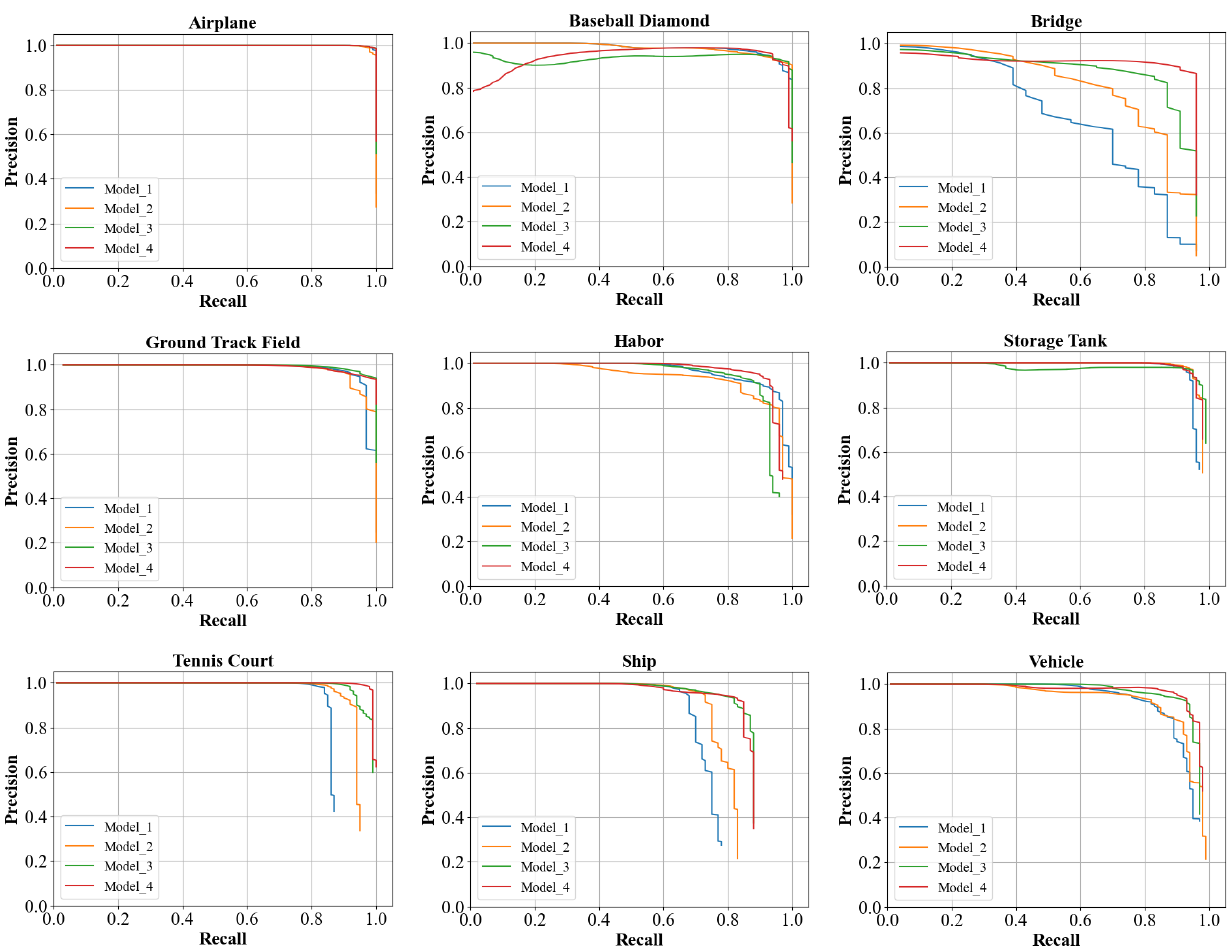
Figure 10. Visualization of PR curves for each